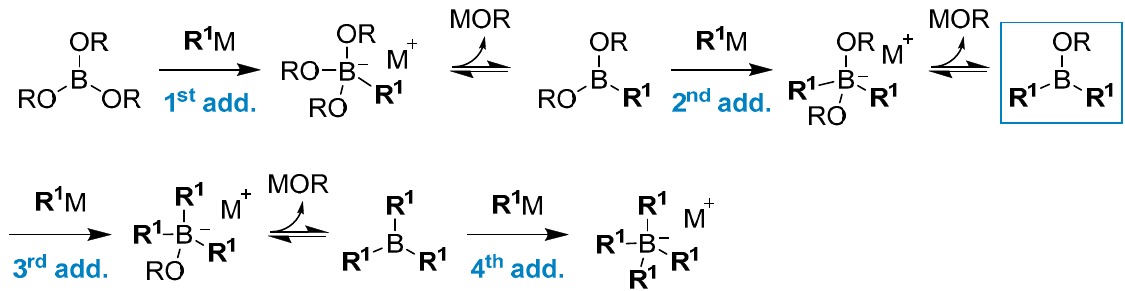
Scheme 2. Addition of organometallic species onto trialkoxyboranes.